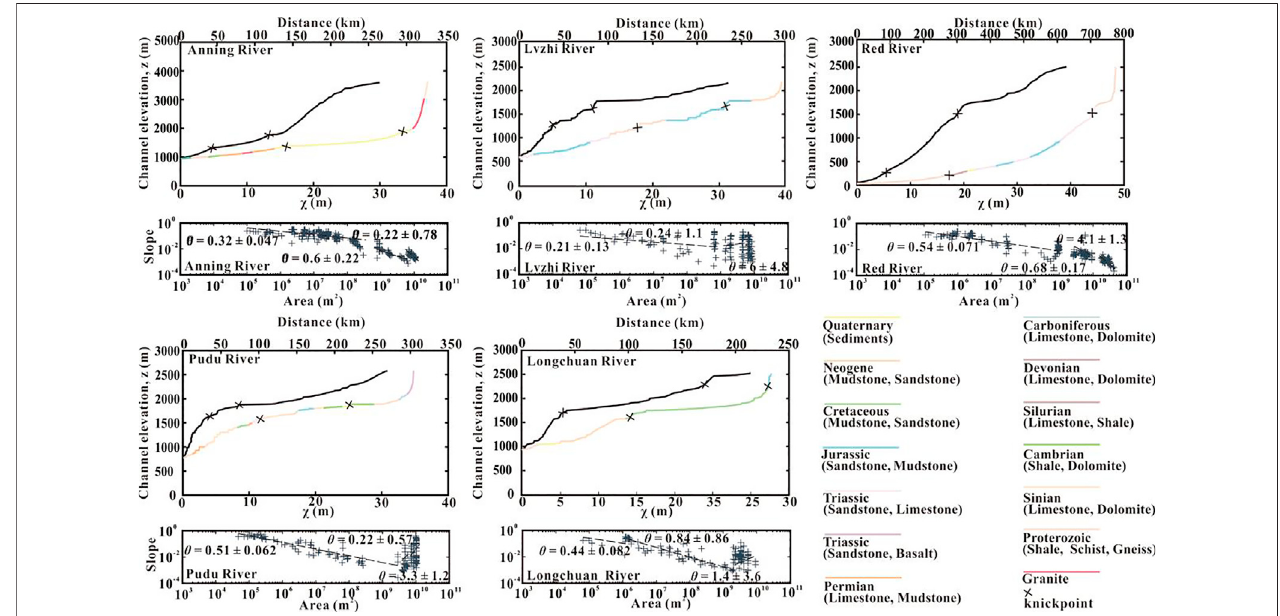
FIGURE 5 | Stream pro fi le analysis for the trunk rivers of the fi ve large drainage basins. The colored curve is a river pro fi le with variable lithologies.